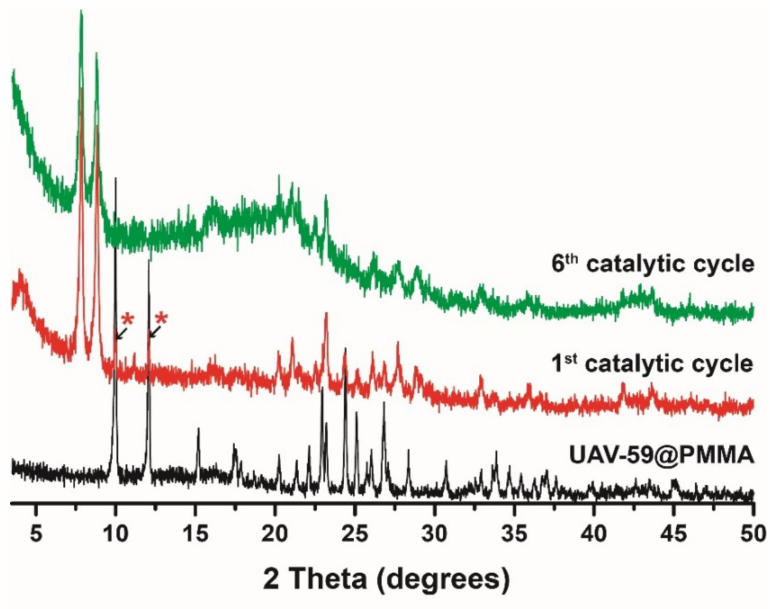
Figure 10. Powder X-ray diffraction of UAV-59@PMMA after the first and sixth catalytic cycles. The asterisks indicate the two main reflections from the parentUAV-59 material still present after the first catalytic cycle.